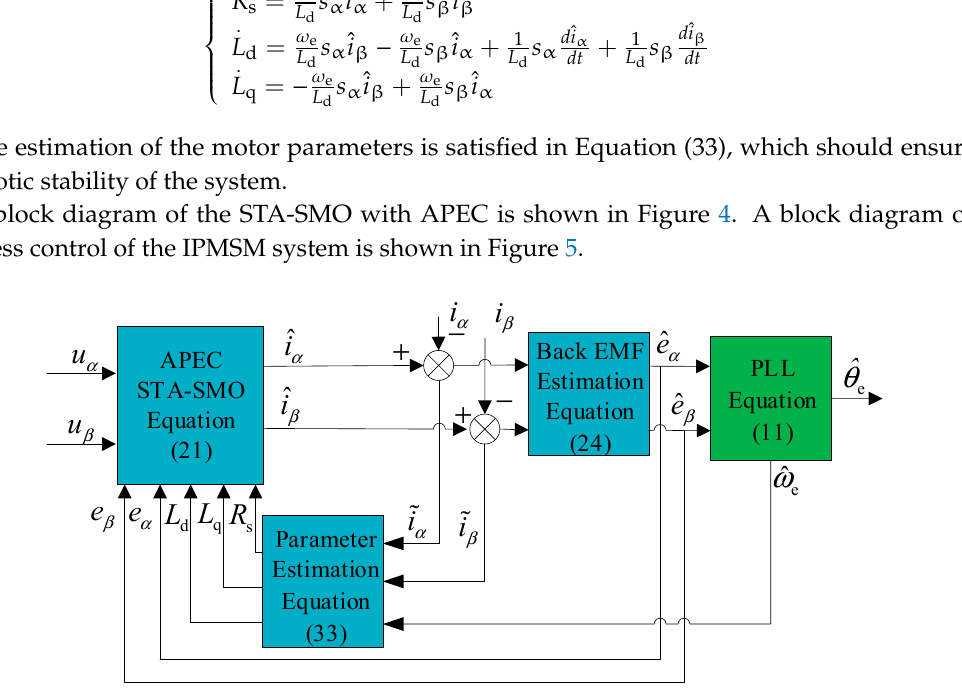
Figure 4. Structure diagram of the sliding mode observer based on the super twisting algorithm (STA-SMO) with adaptive parameter estimation control (APEC).